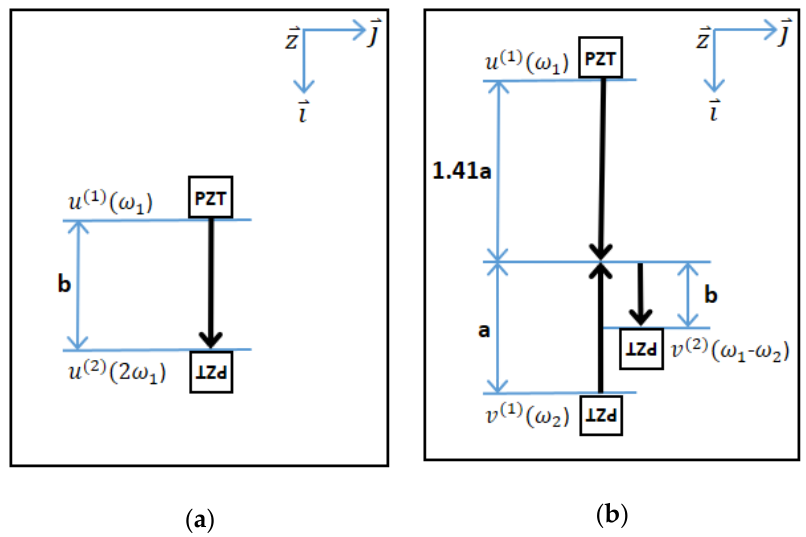
Figure 14. Experimental Setup: ( a ) Phase matching mode; ( b ) Guided wave mixing technique. Table 4. Experimental conditions for phase matching mode technique.